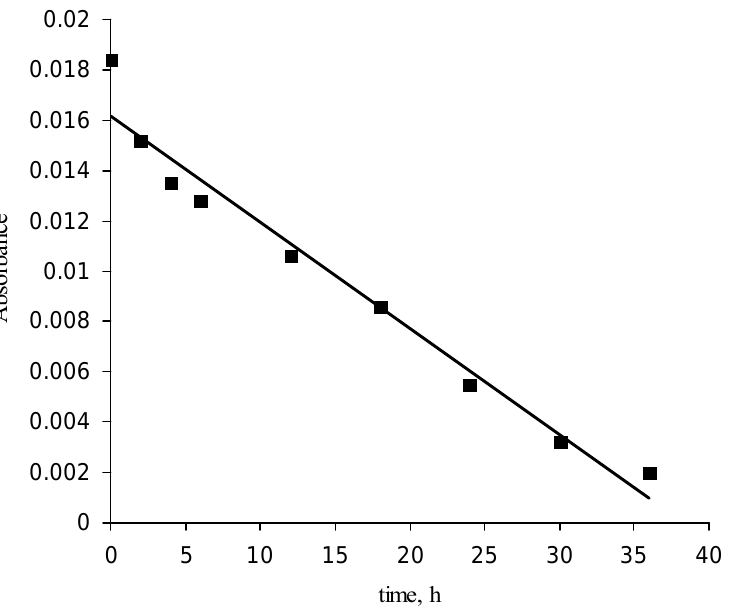
Figure 5. Intensity of the C-H vibration band as a function of UV irradiation time (the measurement was done on copolymer protective layer with thickness of 100